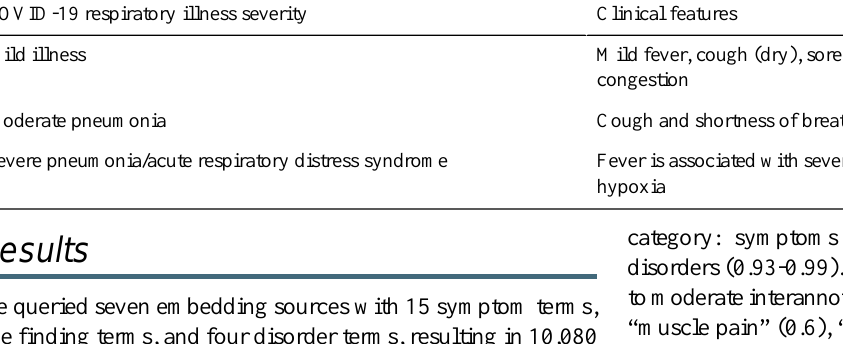
Clinical featuresCOVID-19 respiratory illness severity